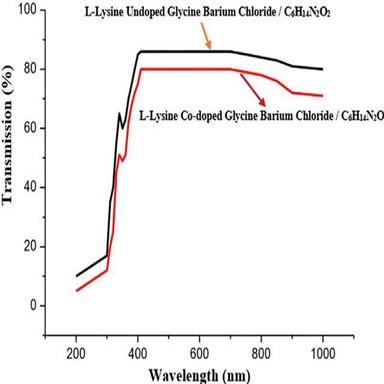
Illustrations Optical transmission of pure and Co-doping L-LGBCAC.